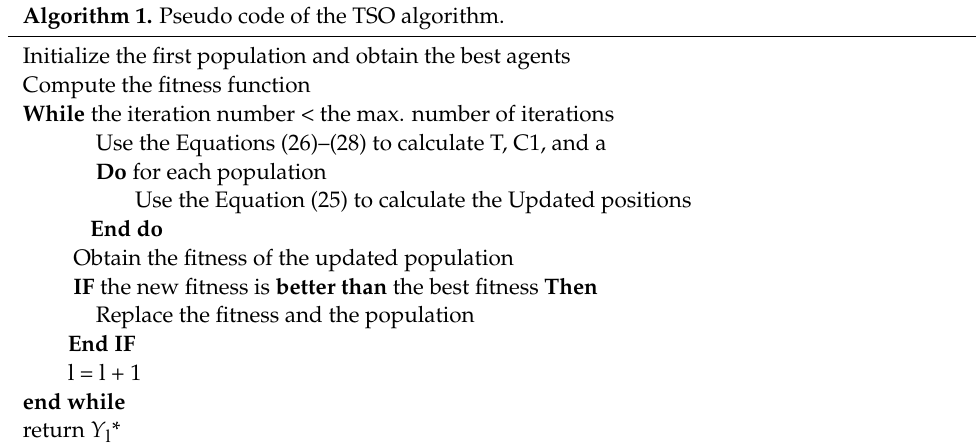
Figure 2. Effect of the variable ‘ T ’ on the exploration and exploitation processes. Algorithm 1. Pseudo code of the TSO